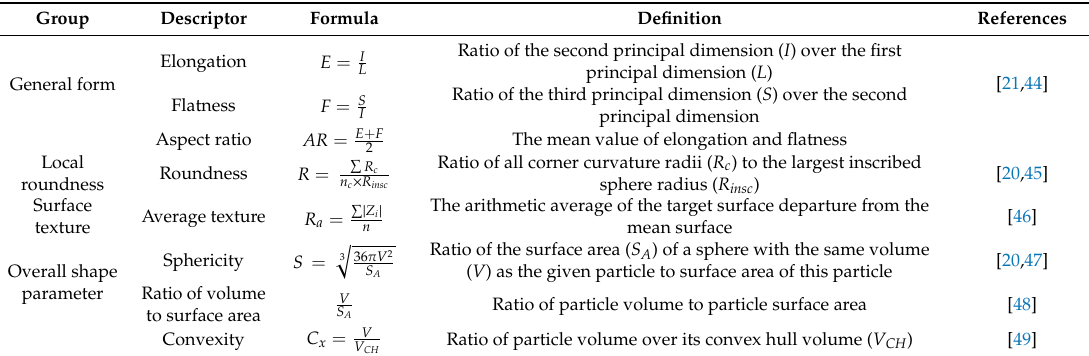
Table 1. Definitions of morphology